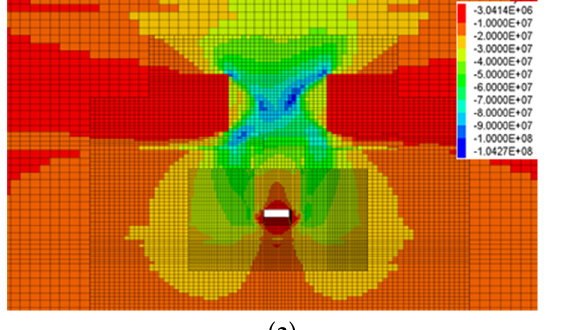
Figure 27. Principal stress distribution contour of the roadway’s surrounding rock when the roadway dug directly below the residual coal pillar. ( a ) σ 1 cloud. ( b ) σ 3 cloud.